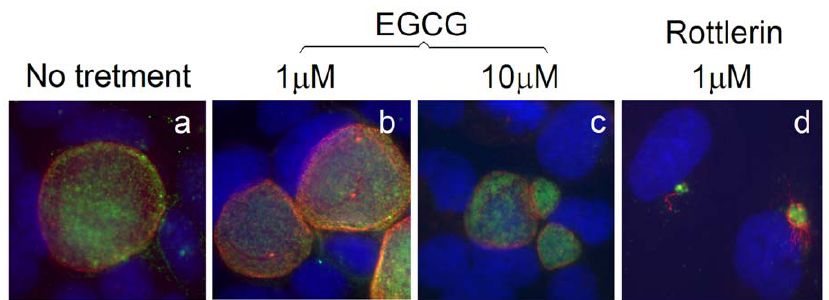
Figure 2. EGCG fails to inhibit chlamydial growth. HeLa cells infected with C. trachomatis (MOI=0.5) were treated with EGCG (1 m M, panel b & 10 m M, c) or rottlerin (1 m M, d) 16 h post infection. The cultures were processed 44 h post infection for immuno-labeling with a rabbit antibody for labeling the C. trachomatis organisms (green) and a mouse monoclonal antibody (clone BB2) for inclusion membrane protein IncA (red). Note that EGCG at 1 m M failed to inhibit inclusion expansion and even at 10 m M only slightly reduced inclusion size while rottlerin at 1 m M completely blocked